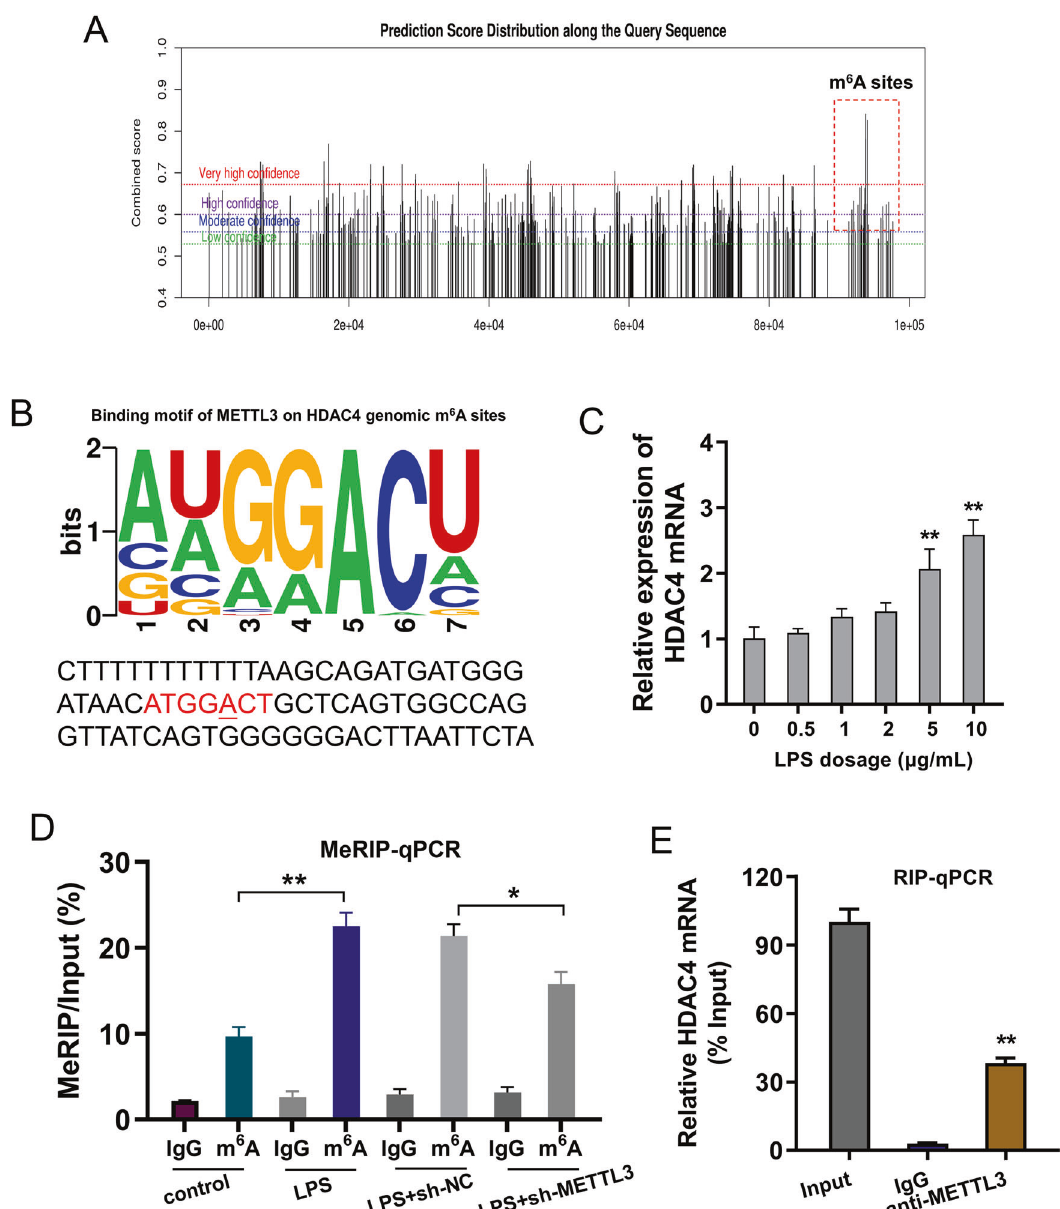
Fig. 3 HDAC4 acted as a target of METTL3 in cardiomyocytes. A The predictive tools using sequence-based N 6 -methyladenosine (m 6 A) modi fi cation site predictor (SRAMP, http://www.cuilab.cn/sramp) revealed the potential m 6 A modi fi cation sites on HDAC4 genome. B The binding motif of METTL3 on HDAC4 m 6 A site was GGACU sequences. C RT-PCR detected the HDAC4 mRNA was detected in cardiomyocytes with the increasing doses of LPS (0, 0.5, 1, 2, 5, 10 μ g/mL). D Knockdown of METTL3 decreased the m 6 A methylation level of HDAC4 mRNA using m 6 A MeRIP-qPCR analysis. E RIP assays re fl ected the interaction of METTL3 and HDAC4 mRNA in cardiomyocytes. Relative enrichment of HDAC4 mRNA associated with METTL3 relative to input was calculated. IgG antibody acted as a control. Biological experiments were performed in triplicate. Data were exhibited as Mean ± Standard Deviation (SD). ** p < 0.01, * p < fi ndings revealed that METTL3/IGF2BP1 enhanced the stability of HDAC4 mRNA.